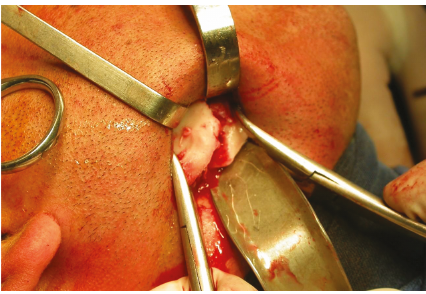
Figure 2: Exposure of the refracted right mandibular angle.